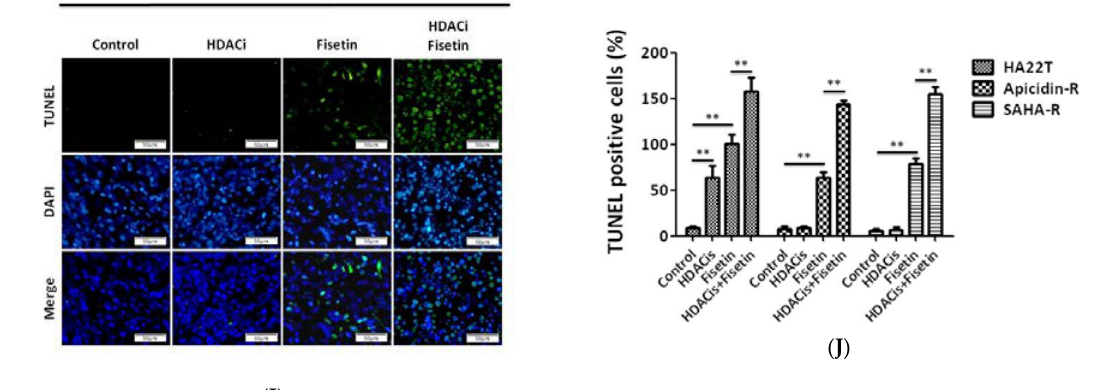
Figure 7. E ff ect of treatment with fisetin and HDAC inhibitors (apicidin, SAHA), both alone and in combination, on HA22T tumors and HDACis-R tumors in athymic nude mice. Tumors from athymic nude mice implanted with HA22T and HDACis-R cells and treated with the vehicle or fisetin or HDAC inhibitors (apicidin, SAHA) alone or in combination were harvested for immunostaining, Western blot analyses and TUNEL assay. ( A ) Tissue sections stained by hematoxylin and eosin (H&E stain). Scale bar = 50 µ m. ( B ) PP1 expression levels (brown color and quantification graph data) in liver tumor samples were examined by IHC analysis. Arrows indicate PP1-immunoreactive cells. Scale bar = 50 µ m. ( C ) Western blotting for the cleavage of caspase-3 and PARP and p-Akt expression. The data presented are from a representative experiment repeated thrice with similar results. ( D ) Quantification of Figure 7C, normalized to GAPDH. * p < 0.05, ** p < 0.01, *** p < 0.001 compared with the control group. ( E ) Protein lysates were examined for the expression of proteins in the ER stress sensor PERK and PP1 signaling pathways. The data presented were obtained from a representative experiment repeated thrice with similar results. ( F ) Quantification of Figure 7E, normalized to GAPDH. * p < 0.05, ** p < 0.01, *** p < 0.001 compared with the control group. ( G – I ) Sections from tumors harvested from mice treated with vehicle, fisetin, or HDAC inhibitors alone or in combination exhibited DNA damage, as determined by TUNEL assays. Scale bar = 50 µ m. ( J ) The apoptosis rate was calculated as the percentage of TUNEL-positive cells among the total number of counted parental and resistant cells (mean ± SD, n = 4). The mean values were significantly di ff erent compared with the control group. * p < 0.05, ** p < 0.01, *** p < 0.001.